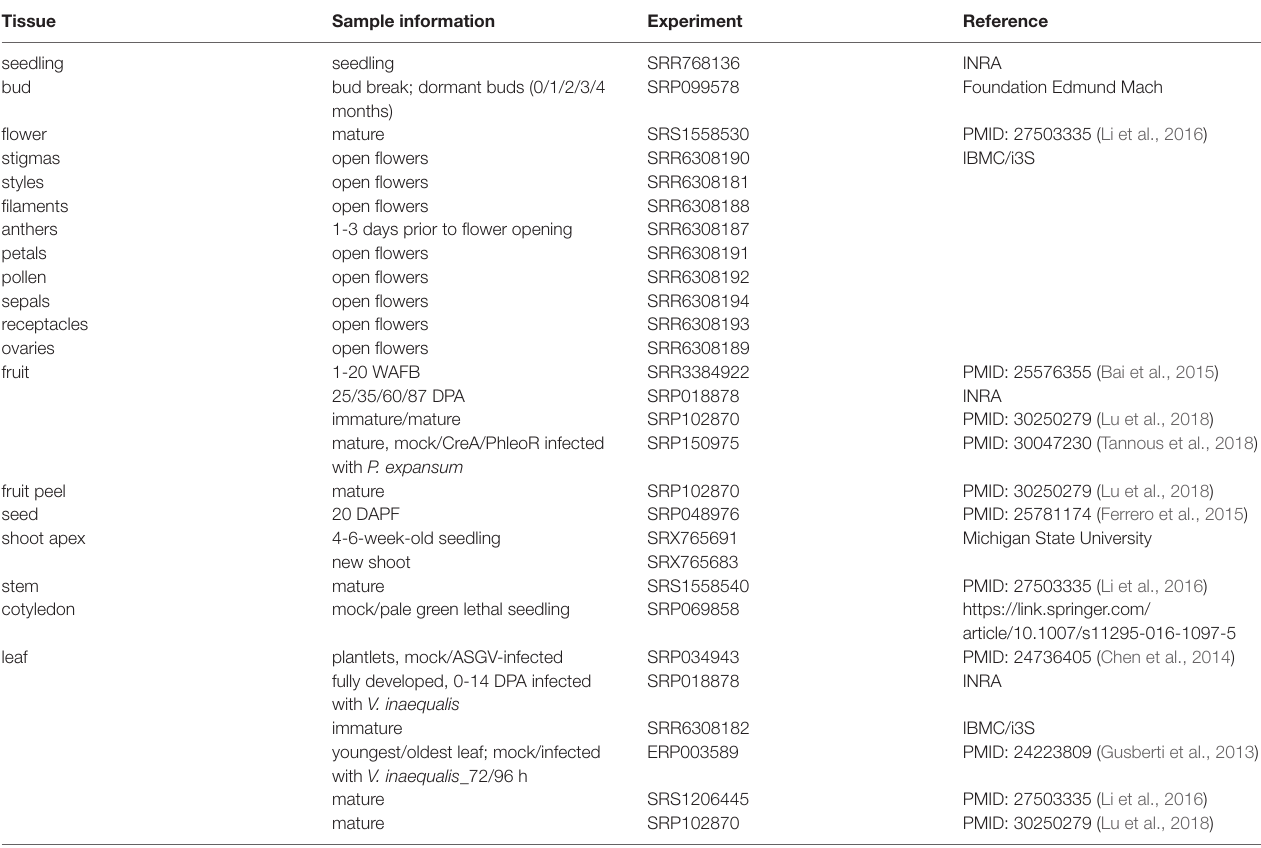
TABLE 1 | RNA-seq data resources.